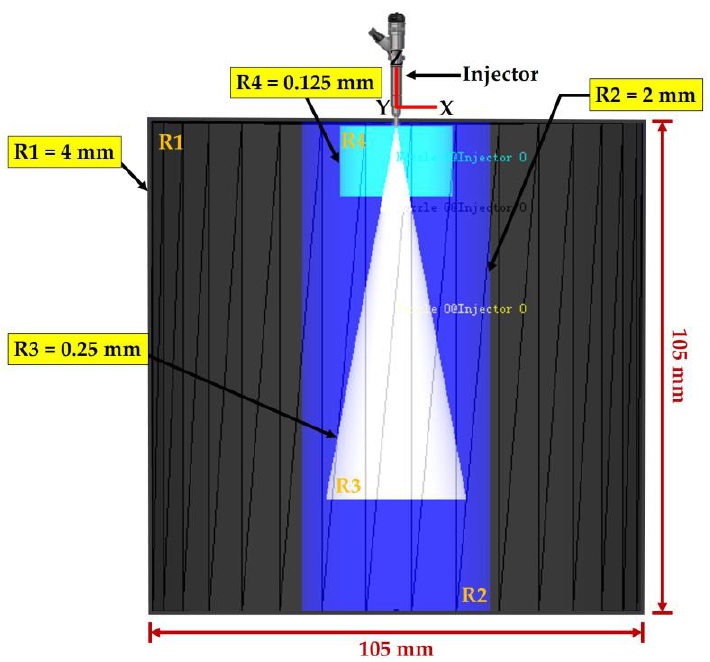
Figure 1. Geometric structure of CVCC and computational domain.